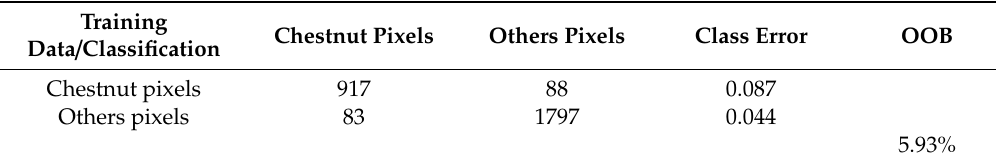
Table 3. Training data classification results for Model 1, including the out-of-bag (OOB) error. Model created using Random Forest (RF). Predictive variables were all of the obtained variables.